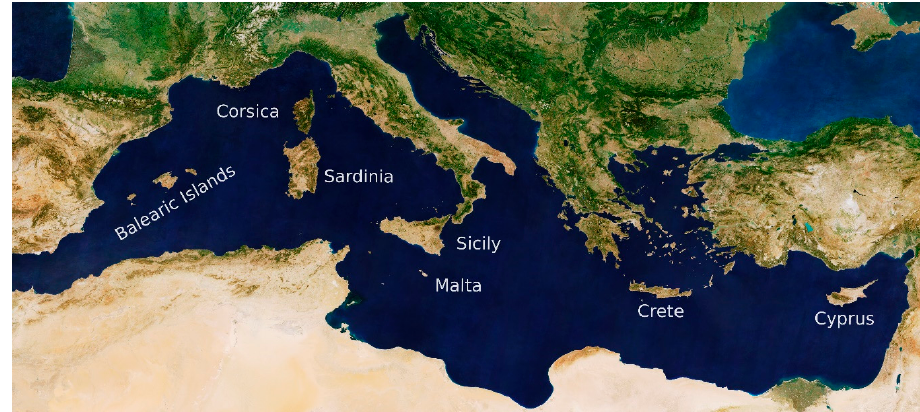
Figure A1. Mediterranean islands considered in the current study.